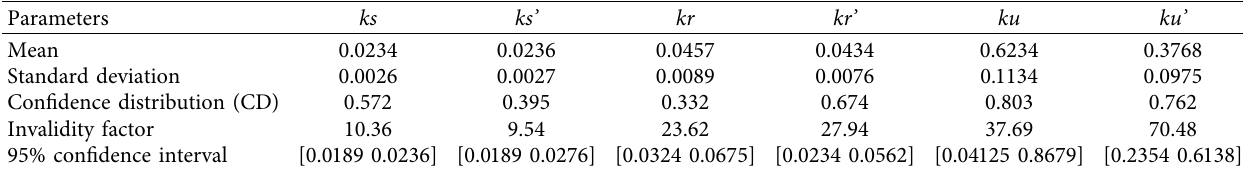
Table 2: Parameter estimation of APM.